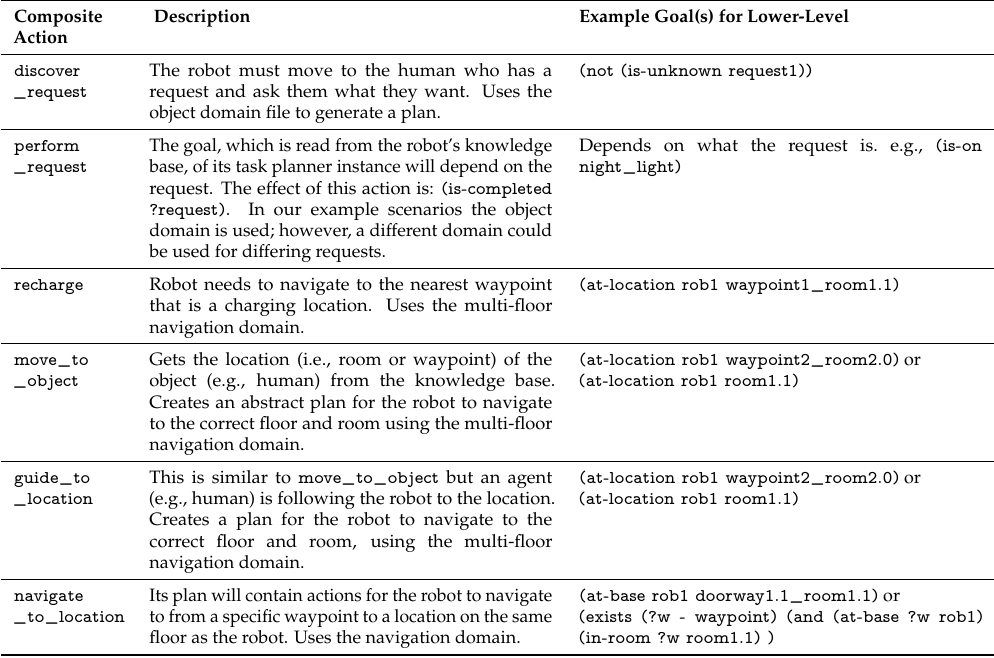
Table A1. Description of composite